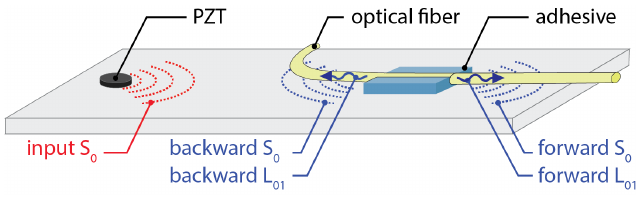
Figure 17. Coupling of S 0 to L 01 modes in optical fiber